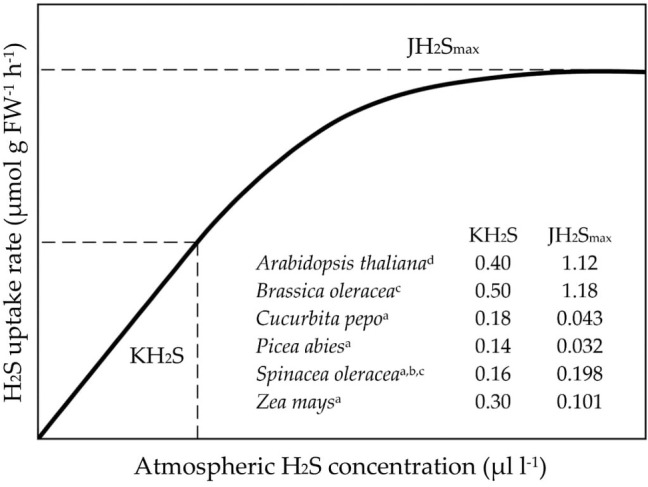
The kinetics of foliar H2S uptake. JH2Smax represents the maximum uptake rate of H2S and KH2S the concentration at which ½JH2Smax is reached. FW: fresh weight. Figure modified after De Kok et al. (2002). Data derived from De Kok et al. (1989a, 1991b, 1997c) and Van der Kooij and De Kok (1998d).